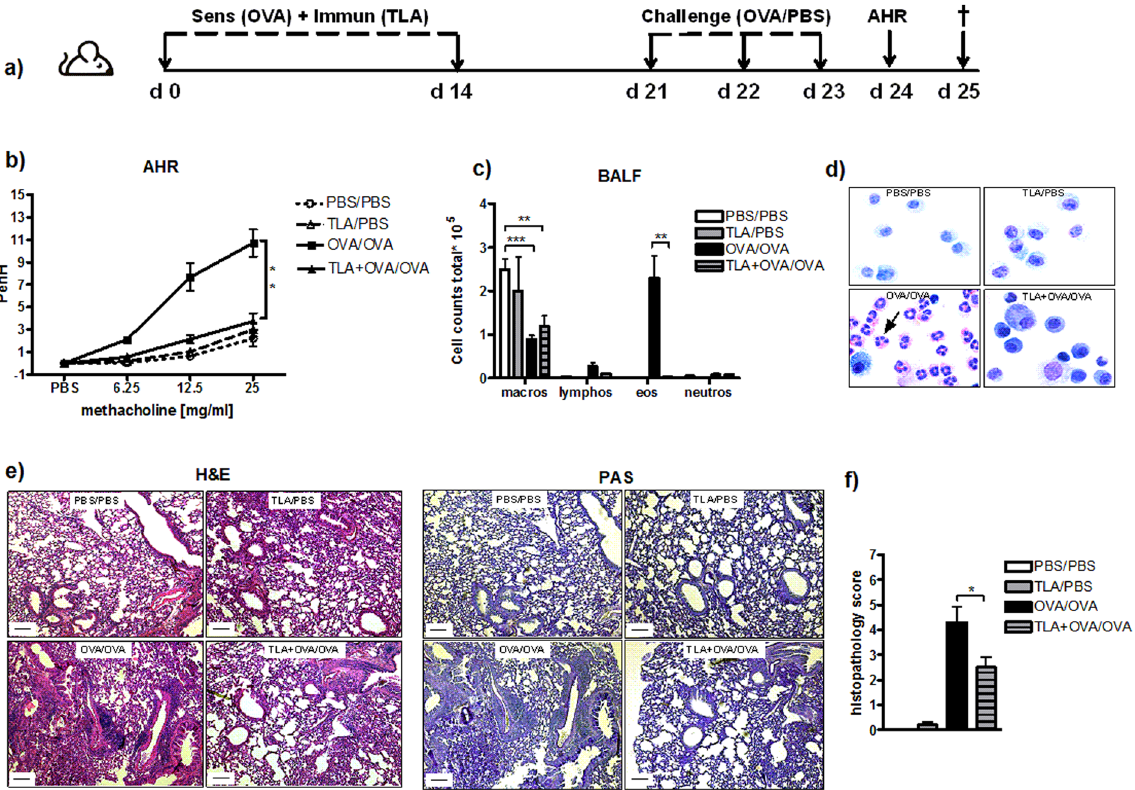
Figure 3. Effect of TLA on the development of allergic airway inflammation. Mice were immunized intraperitoneally with 50 µ g of TLA admixed to 10 µ g of ovalbumin in alum (TLA + OVA/OVA group) on day 0 and 14 and intranasal challenge with 100 µ g of OVA was given at days 21–23. Control groups were immunized with 10 µ g of ovalbumin in alum (OVA/OVA), 50 µ g TLA in alum (TLA/PBS) and PBS in alum (PBS/PBS) and challenged with OVA or PBS ( a ). Airway hyperresponsiveness (AHR) was assessed in the response to inhalation of increasing doses of methacholine on day 24 ( b ). Number of differential cells in bronchoalveolar lavage (BALF) ( c ) and representative cytospins of BALF stained with haematoxylin and eosin (H&E; 100x magnification; arrow indicates eosinophil) ( d ). Representative lung tissue sections stained with H&E and Periodic Acid Schiff (PAS; 40x magnification; scale bars, 100 µ m) ( e ). Mean gross lung histopathology score ( f ). Data are representative of three experiments (n = 5 mice per group). Results of ANOVA test: * P < 0.05, ** P < 0.01, *** P <